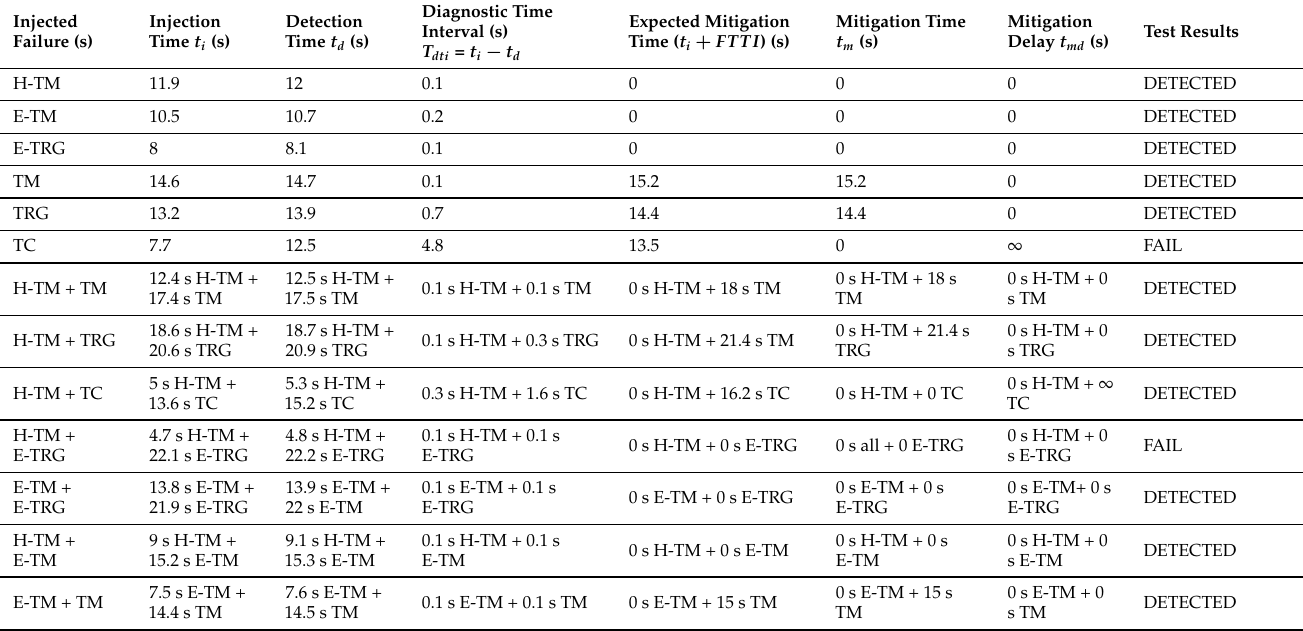
Table 8. Simulation results for the traction